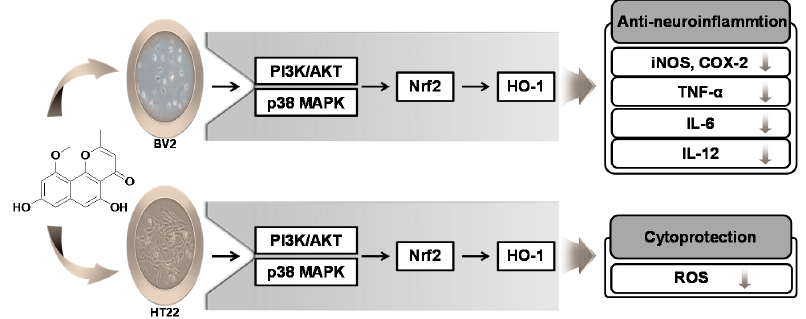
Figure 12. The suggested mechanism for the anti-neuroinflammatory and cytoprotective effects of TMC-256C1 in HT22 and BV2 cells. TMC-256C1 increased cellular resistance to oxidative injury induced by glutamate-induced oxidative cytotoxicity in HT22 cells, via Nrf2-dependent HO-1 expression. In BV2 cells, TMC-256C1 inhibited the LPS-induced production of pro-inflammatory mediators possibly through the Nrf2-dependent HO-1 expression. Especially, PI3K/Akt and p38 MAPK regulate the Nrf2 activation in both HT22 and BV2 cells.